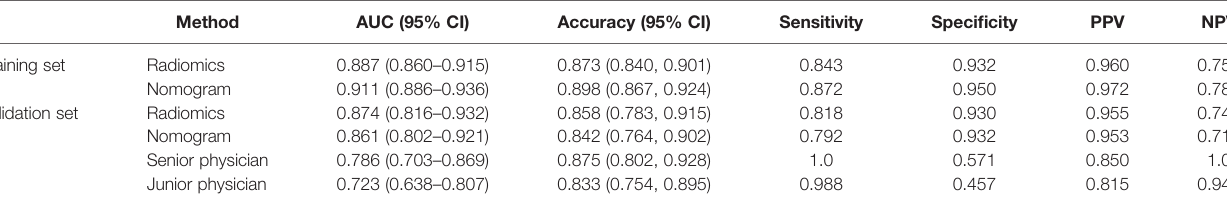
TABLE 2 | Diagnostic performance of radiomics signature, radiomics nomogram, senior physician, and junior physician in the validation set.